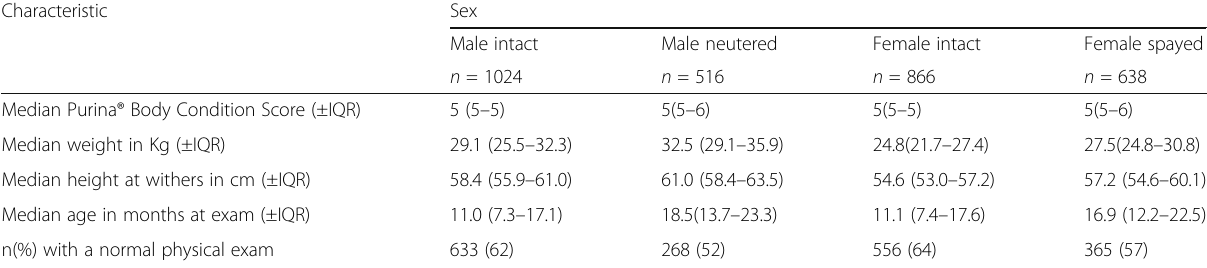
Table 3 Results from physical examination on 3044 Golden Retriever dogs at their initial clinical study visit